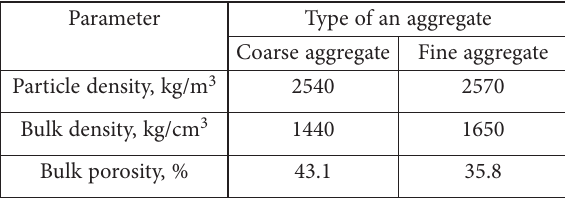
Table 2. Characteristics of aggregates